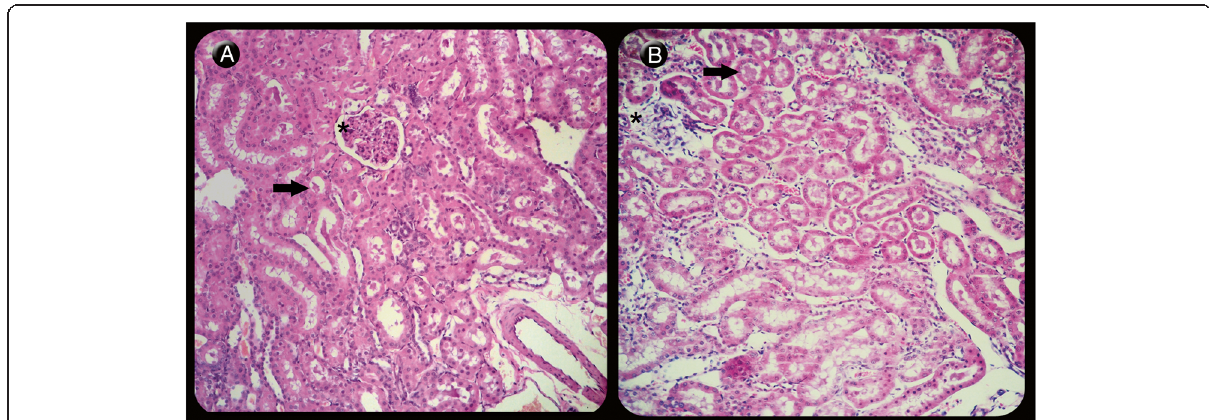
Figure 6 Light microscopy of renal longitudinal sections of rats stained with hematoxylin-eosin. (A) Kidney showing mild degenerative changes in tubules (arrow) and glomeruli (asterisk) in the control group (PLA) (210×) when compared to (B) the group that received 120 pmol of MVIIC (G120), revealing severe degeneration in the Bowman ’ s space, glomerular (asterisk) and tubular epithelial cells with deposition of eosinophilic material inside renal tubules (arrow) (207×).